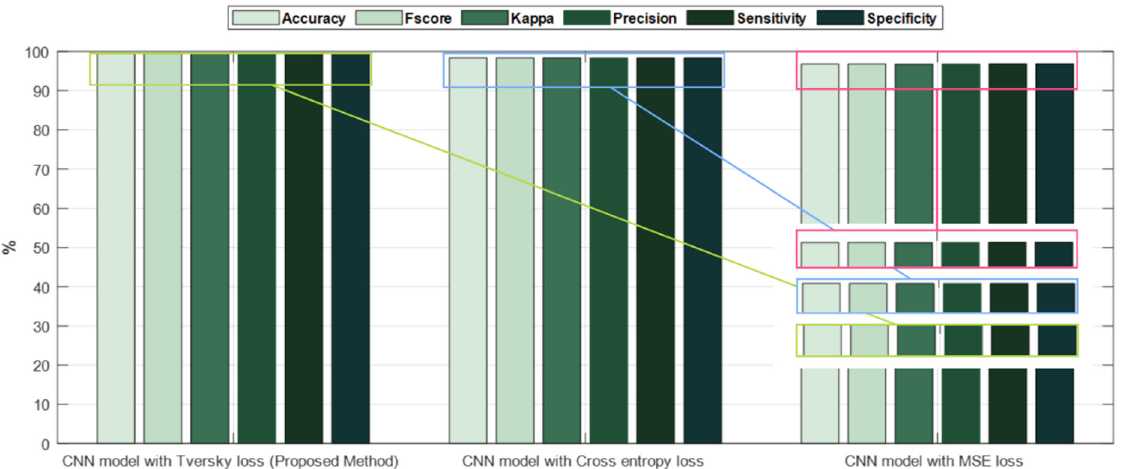
Figure 12. Bar chart plots of accuracy, fscore, kappa, precision, sensitivity, and specificity for the proposed customized CNN model with the Tversky loss function compared with the CNN model with the cross-entropy and MSE loss functions.